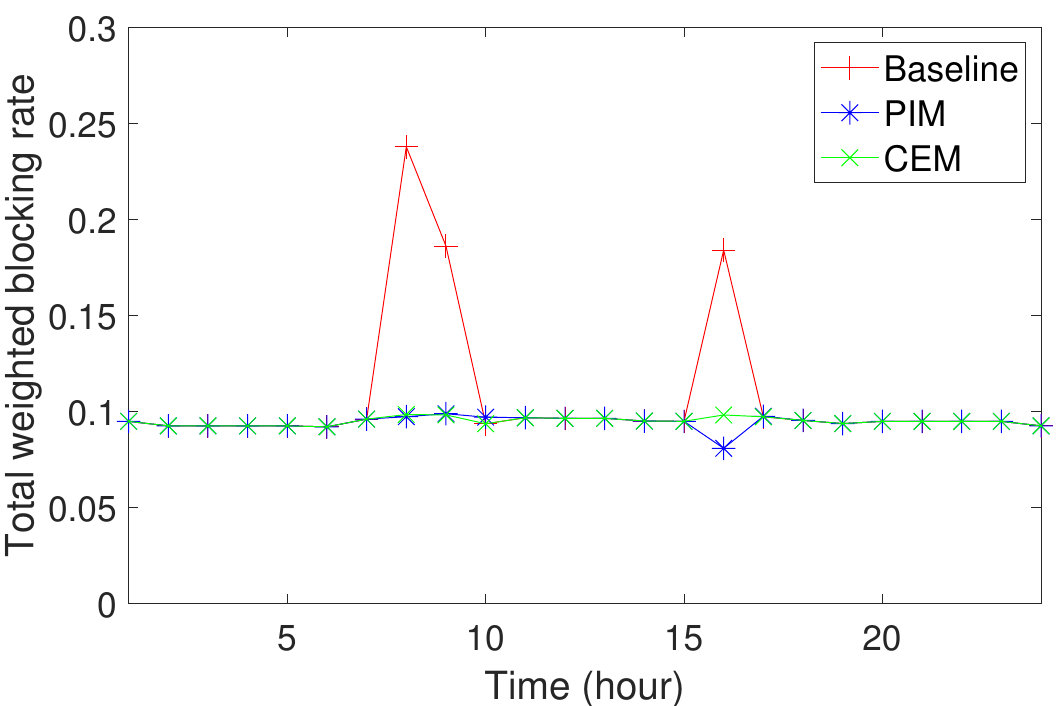
Figure 7. Comparison of weighted blocking